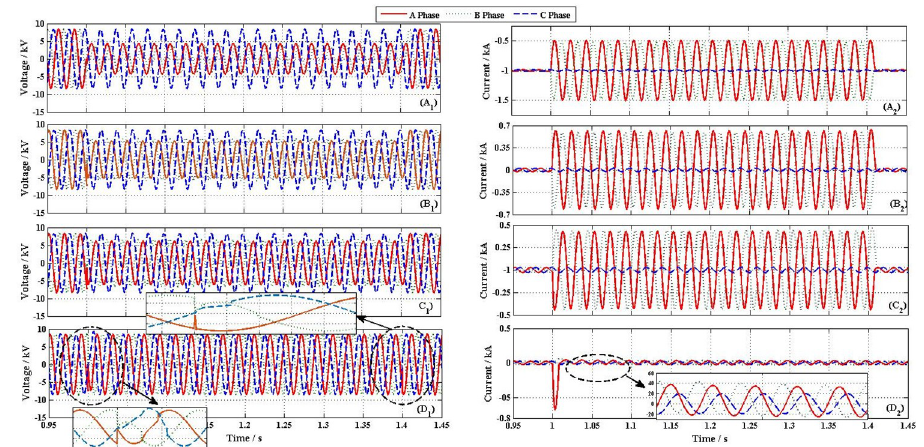
Fig 11. Transient performances curve of distribution network. (A 1 ) Voltage of BUS1 without FCL (A 2 ) Output current of BUS1 without FCL (B 1 ) Voltage of BUS1 with SFCL = 5 O (B 2 ) Output current of BUS1 with SFCL = 5 O (C 1 ) Voltage of BUS1 with SFCL = 10 O (C 2 ) Output current of BUS1 with SFCL = 10 O (D 1 ) Voltage of BUS1 with NFFCLs (D 2 ) Output current of BUS1 with NFFCLs.